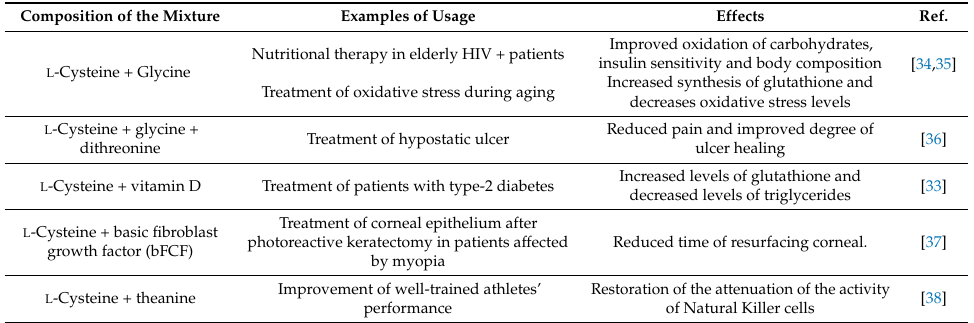
Table 3. Summary of the potential effects of L -Cys (combined with other compounds) supported by studies based on clinical